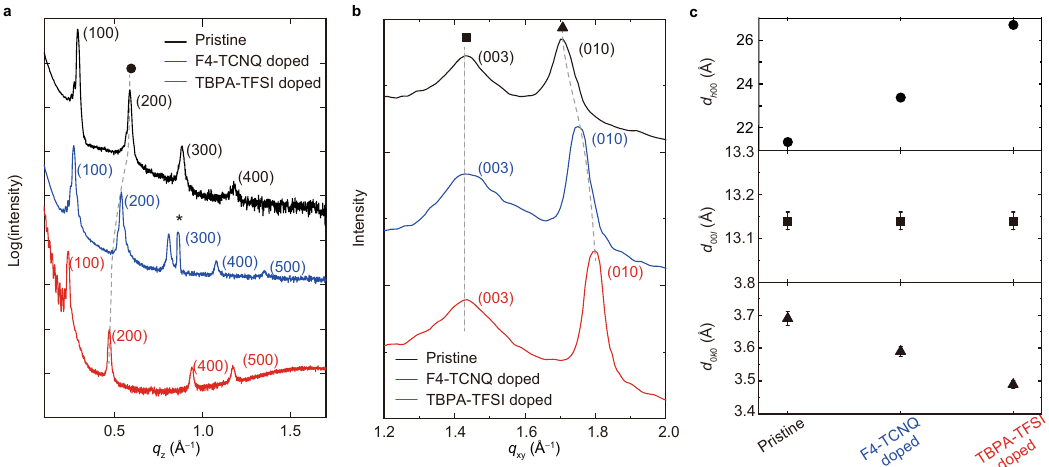
Fig. 2 Out-of-plane and in-plane XRD measurements of chemically doped PBTTT thin fi lms. a Out-of-plane XRD measurements of chemically doped PBTTT thin fi lms. The peak marked with an asterisk is attributed to aggregated F4TCNQ on the surface of the thin fi lm. b In-plane XRD measurements of chemically doped PBTTT thin fi lms. The peaks with the square markers are mainly attributed to the periodicity of the PBTTT backbone in the main chain direction, while the peaks with the triangle markers arise from the periodicity of π stacking of the PBTTT. c d -spacings extracted from XRD measurements, where d h 00 corresponds to stacking of PBTTT sheet structures in the out-of-plane direction, d 00 l corresponds to the length of the repeating unit of the PBTTT backbone, and d 0 k 0 corresponds to the π stacking distance in the in-plane direction. The error bars for the d -spacings were determined from uncertainties in the fi tting and represent one standard deviation.